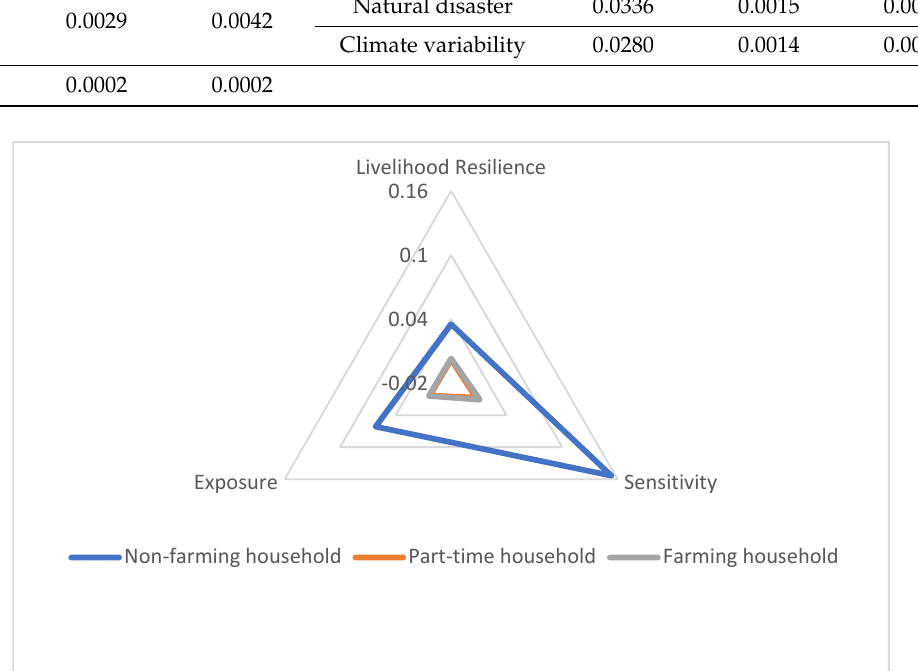
Figure 4. Triangle diagram of vulnerability of different types of livelihoods strategies based on IPCC-LVI scores. (Source: the author, 2021).